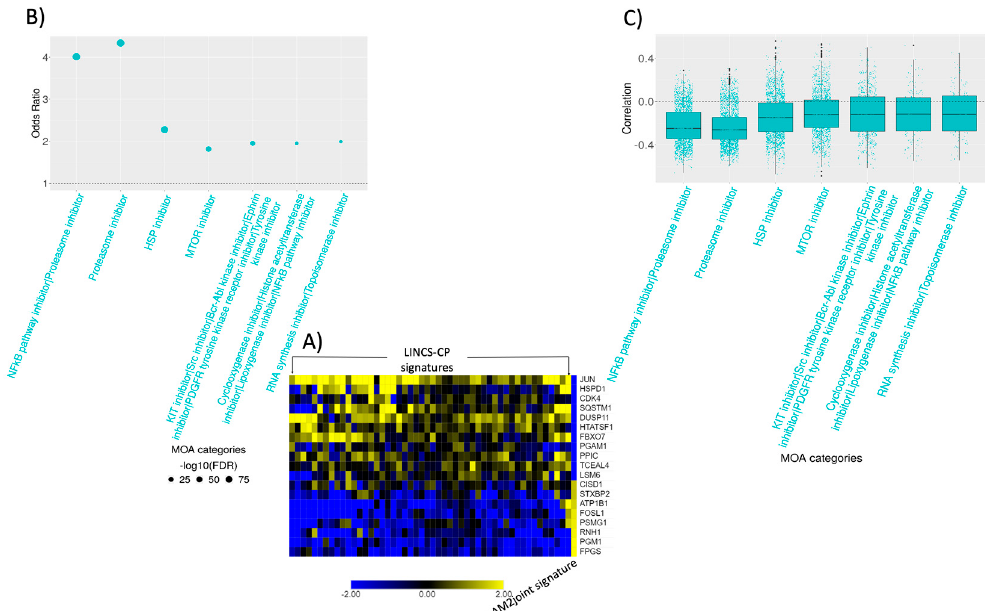
Figure 6. Connectivity analysis of sirolimus-treated LAM signature. ( A ) Top 250 most up/down regulated genes from LAM2 DCS signature was selected and matched with 978 LINCS-L1000 landmark genes. Pearson’s correlation was computed between each of the LINCS-CP and LAM signature. Top 50 LINCS-CP signatures most negatively correlated with the LAM signature (columns) and the corresponding matched genes (rows) are presented via heatmap. ( B ) Odds ratios of the most enriched MOA categories are shown via dot plot where the size of the dots represents the significance of the MOA categories with a bigger dot indicating lower FDR adjusted p -value. MOA categories were selected based on odds ratio > 1.75, − log10(FDR) > 4, and at least 150 signatures in any MOA category. ( C ) Distribution of the overall signature correlations associated with each of the MOA categories are demonstrated via box-and-whisker plots. Each dot represents a LINCS-CP signature, and negative correlations indicate the potential of the drug mechanisms to revert the LAM signature.